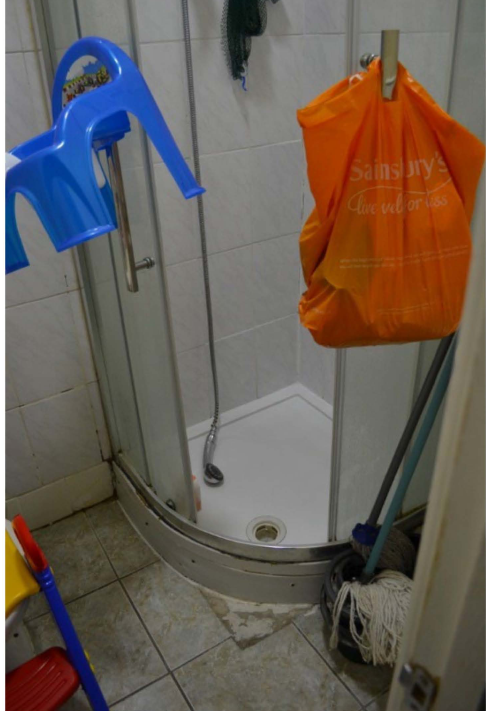
Figure 15. House